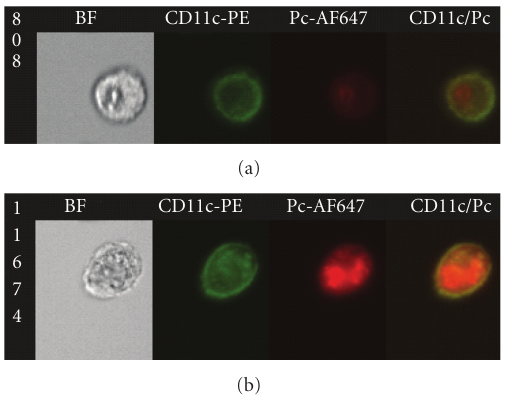
Figure 2: SSZ enhances CD4 + -T-cell-dependent AM phagocytosis of Pc. BAL cells were collected from PBS- and SSZ-treated mice at day 18 (17/18) post-reconstitution. Cells were stained with anti- bodies specific for CD11c (green) and Pneumocystis (red). Imaging flow cytometry was used to measure Pneumocystis internalization by AMs. Representative images of bright field (BF), CD11c, Pc, and merged CD11c/Pc are shown for PBS- (a) or SSZ-treated (b) mice following immune